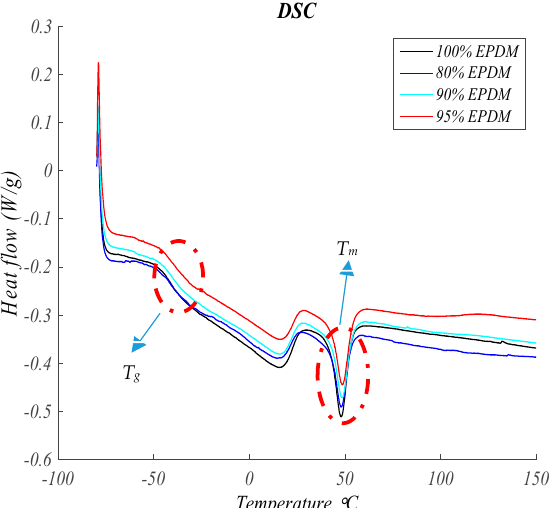
Figure 3. Heat flow versus Temperature at 10 °C/min for EPDM and EPDM and GTR samples. Table 2. Glass transition temperature ( T g ), melting peak ( T m ), and enthalpy of fusion for EPDM and GTR + EPDM